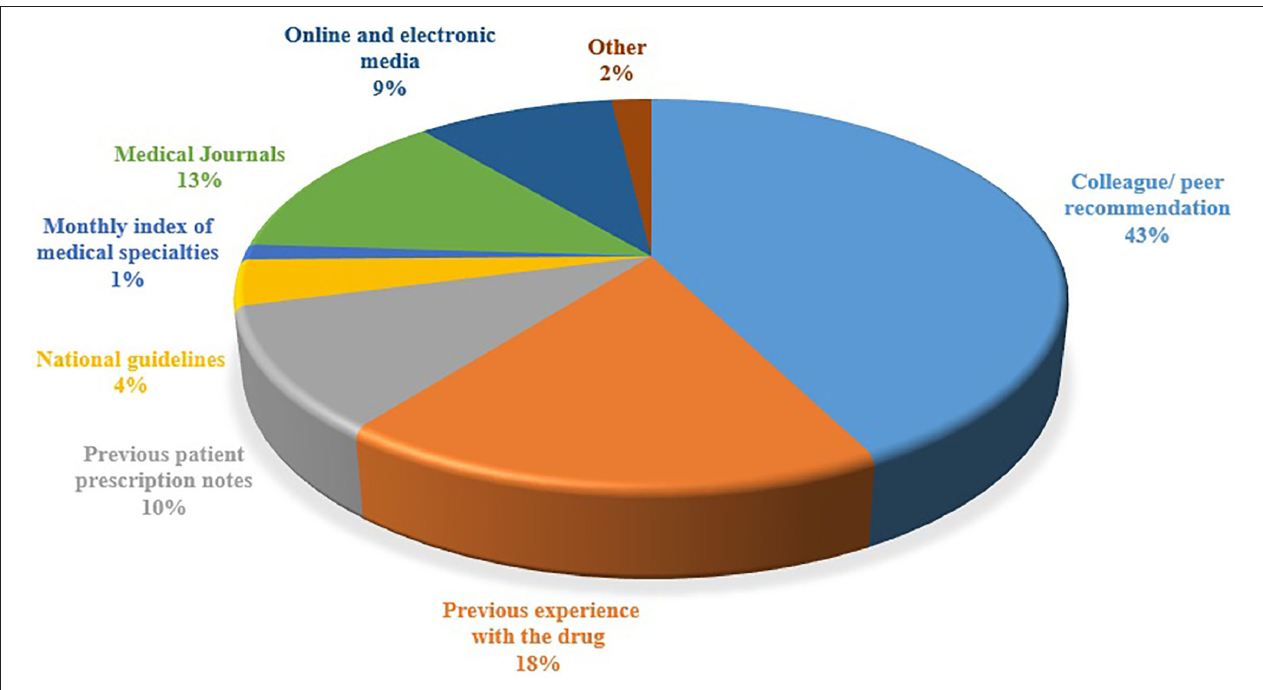
FIGURE 5 | Respondents’ major sources of